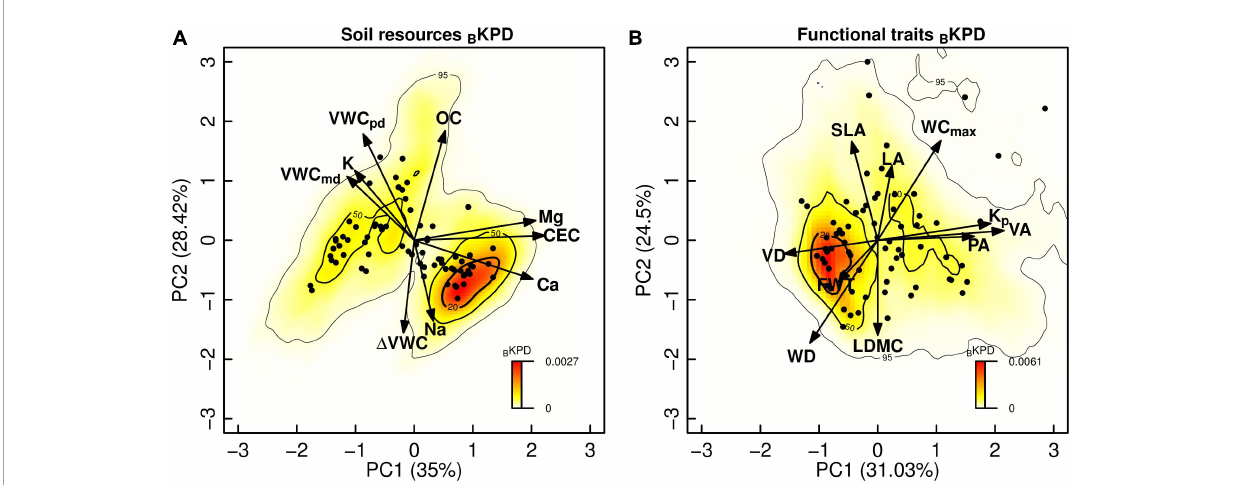
FIGURE1 Bivariate kernel probability densities of the biomass stocks of TDF tree species ( B KPD) showing the spatial variation of soil conditions (A) and functional trait combinations (B) . Soil variables: predawn soil volumetric water content (VWC pd ,%), midday soil volumetric water content (VWC md ,%), daily soil volumetric water content change ( (cid:49) VWC,%), cation exchange capacity (CEC, cmol c kg − 1 ), exchangeable bases [Calcium (Ca), Magnesium (Mg), Potassium (K), Sodium (Na), cmol c kg − 1 ] and organic carbon (OC,%). Functional traits: leaf area (LA, mm 2 ), leaf dry matter content (LDMC, mg g − 1 ), specific leaf area (SLA, mm 2 mg − 1 ), wood density (WD, g cm − 3 ), fiber wall thickness (FWT, µ m), water content at maximum capacity